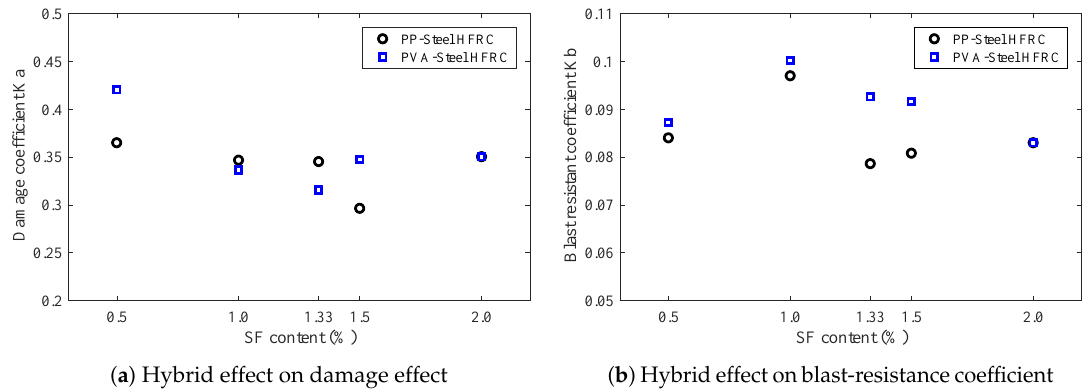
Figure 15. Hybrid effect in terms of damage effect and blast-resistance